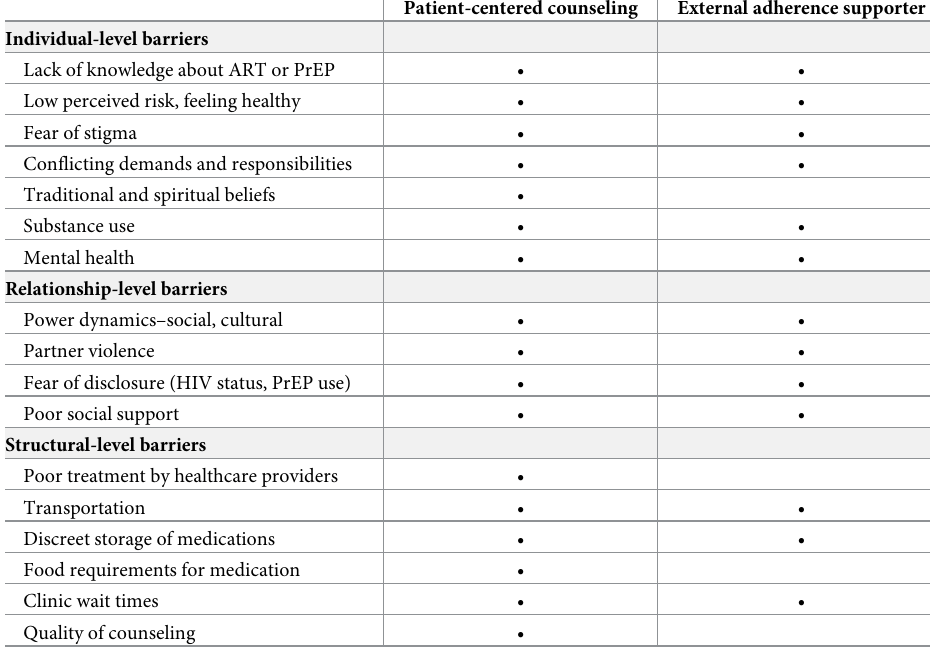
Table 1. Potential barriers to antiretroviral therapy and/or HIV pre-exposure prophylaxis adherence, as identi- fied in a technical consultation meeting (September 2018), mapped to recommended intervention